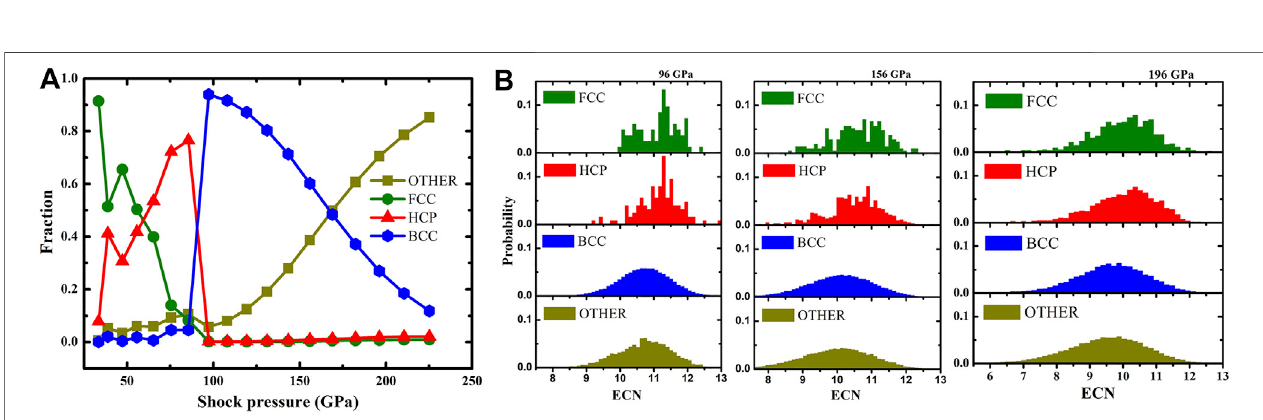
Figure S1 Based on the EAM potential of Cu developed by Mishin et al. , the equation of states in this work matched well with previous results as shown in Supplementary Figure S2A .